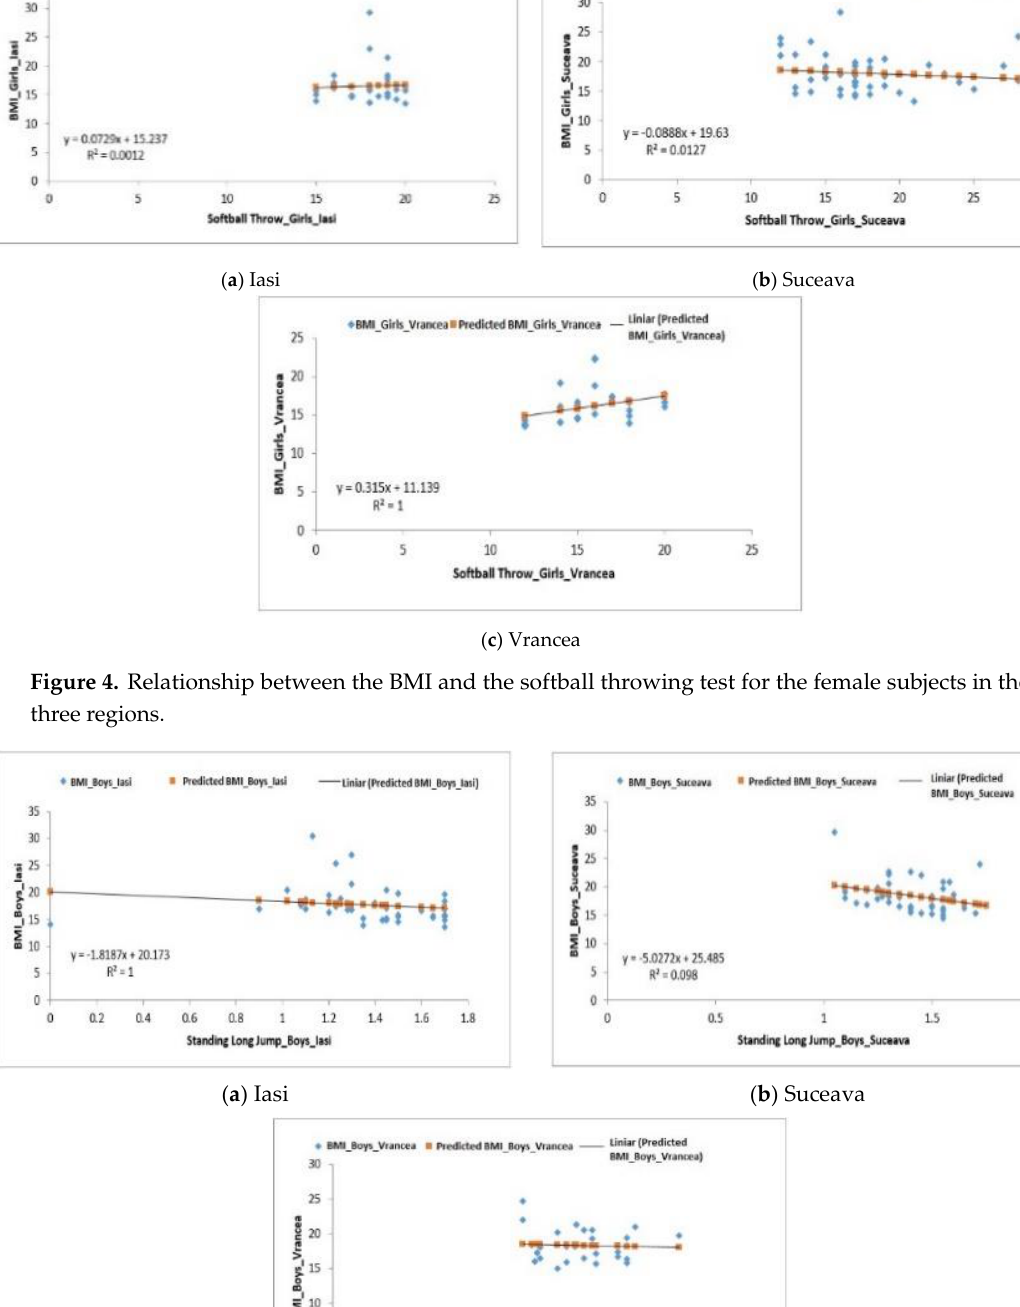
Figure 5. Relationship between the BMI and the standing long jump test for the boys in the three